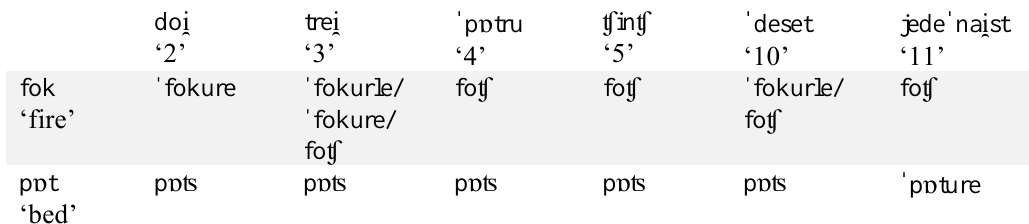
Table 7. Arbitrary selection of pluralizing strategies in responses from